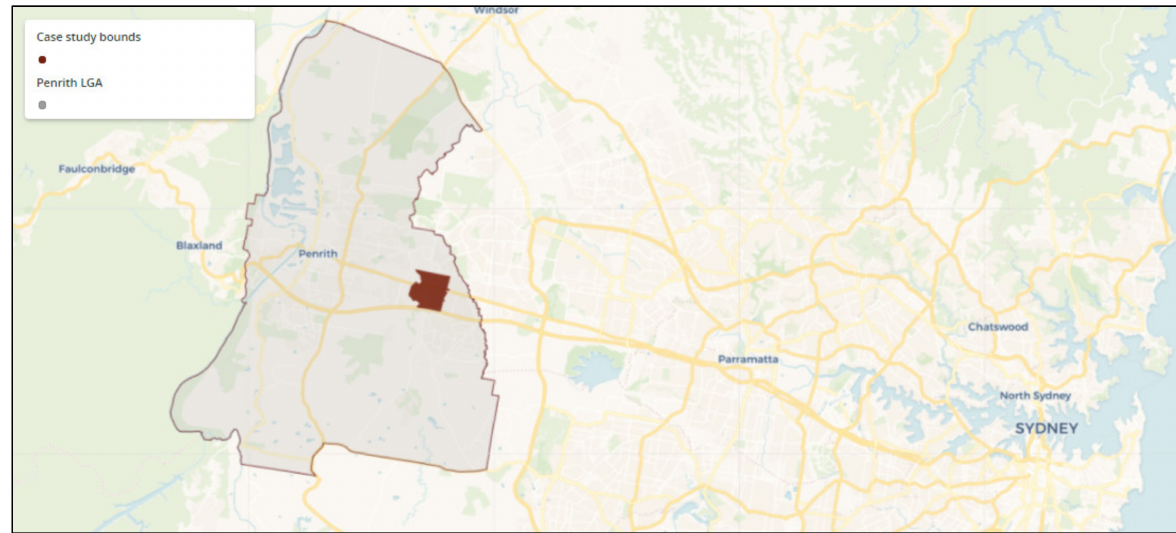
Figure 2. The location of the case study in the Penrith LGA.